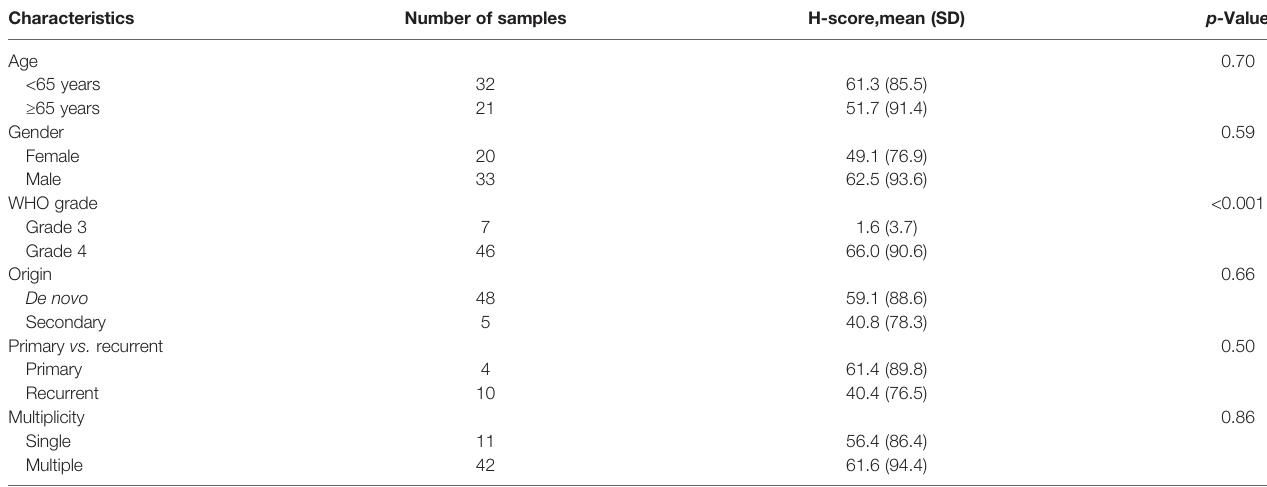
Characteristics